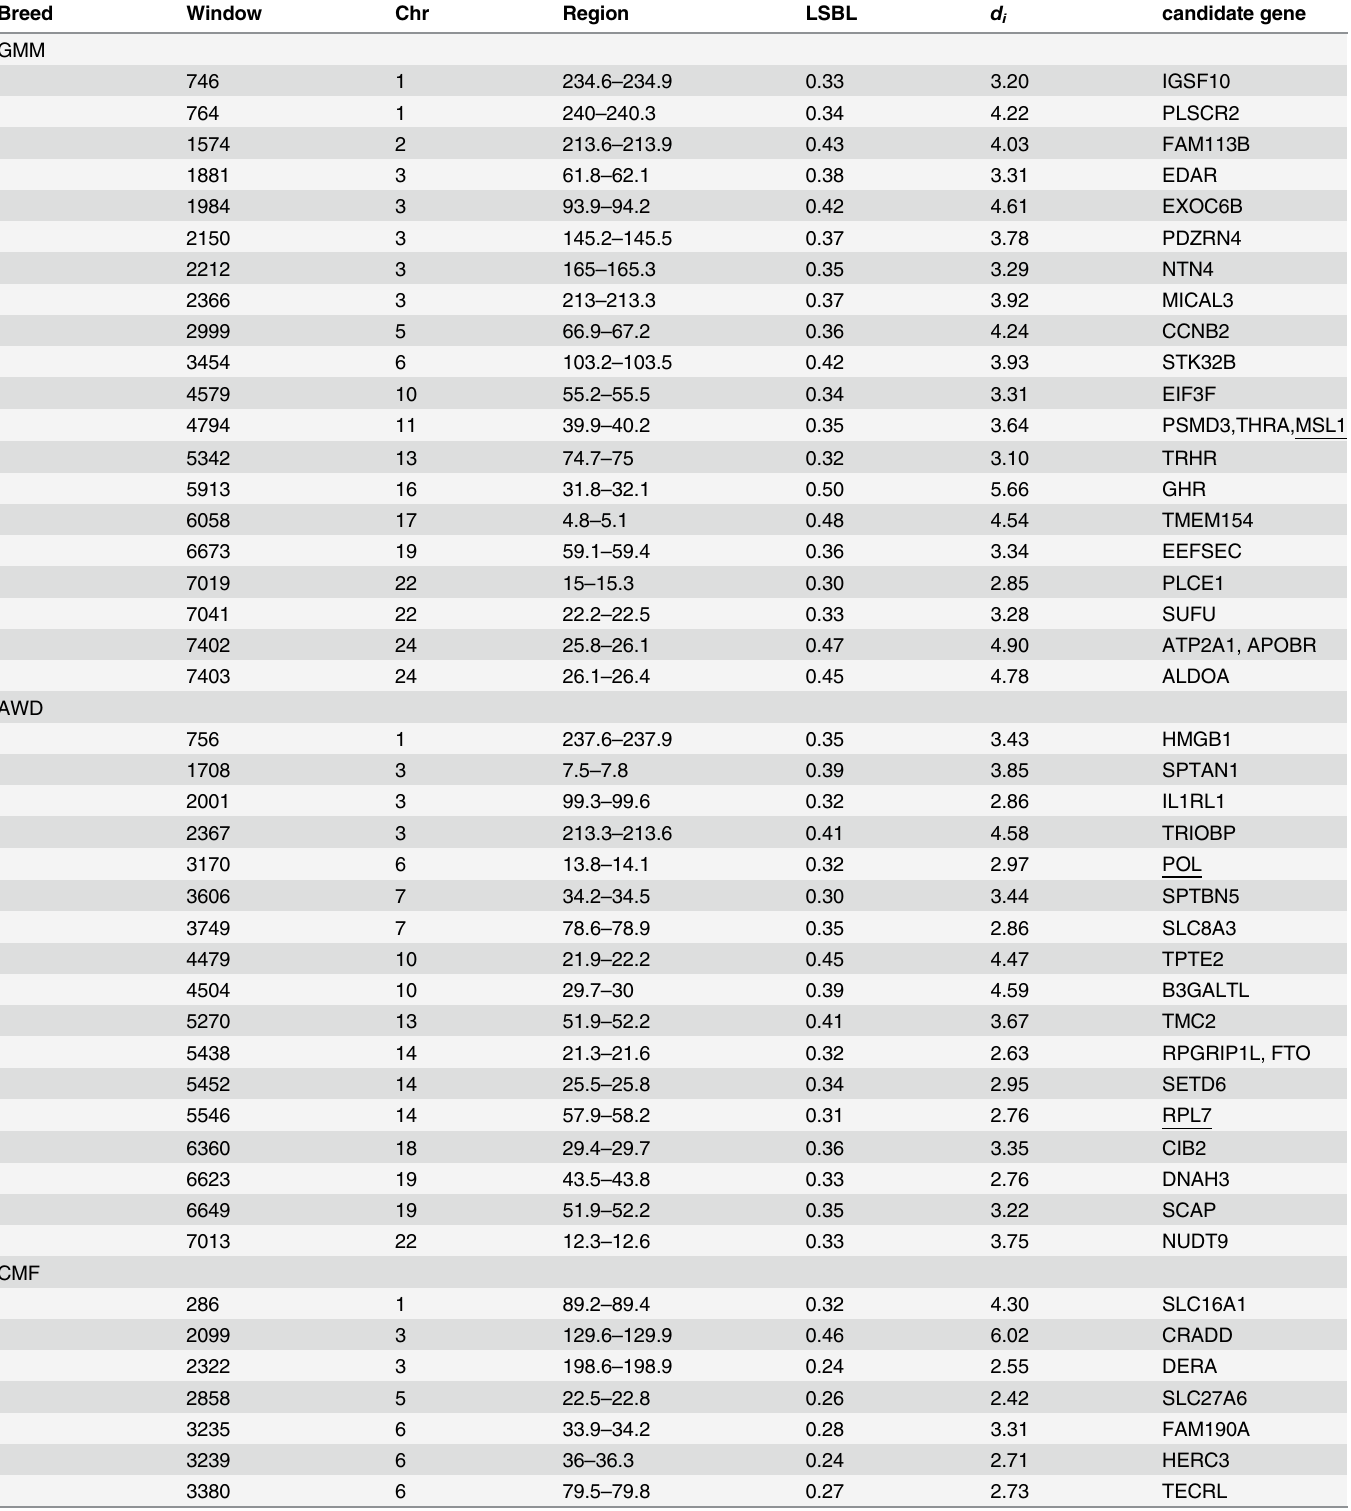
Table 3. The information of main candidate gene of three breeds.